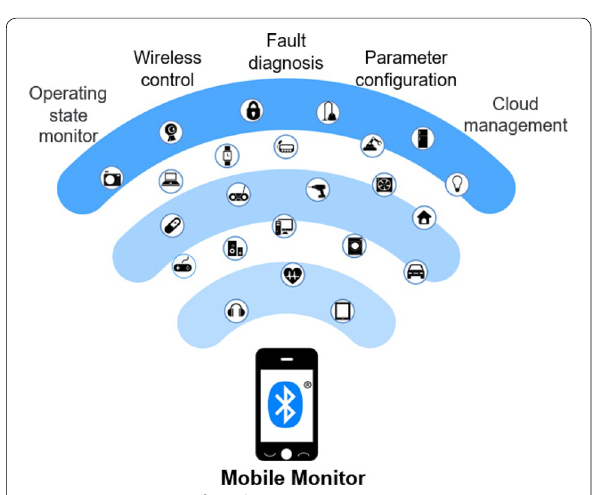
Figure 15 Function of wireless